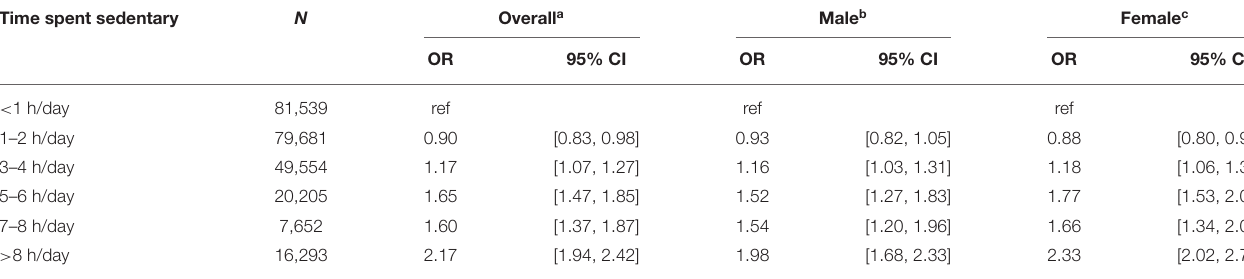
TABLE 1 | The relationship between sedentary time and anxiety-induced sleep disturbance estimated multivariable logistic regression (overall and by gender). Time spent sedentary N Overall a Male b Female